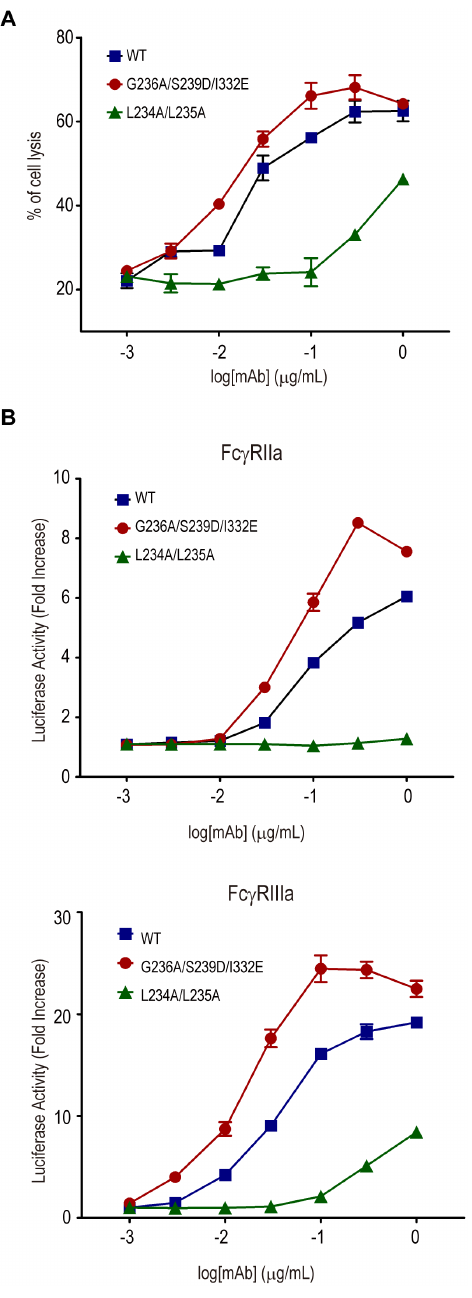
Figure 2. Activation of Jurkat/Fc c R/NFAT-Luc cells by CD20- bound rituximab. (A) Daudi and human PBMC were co-cultured (the effector to target cell ratio was 20:l) in the presence of serially diluted rituximab or its Fc-engineered variants: G236A/S239D/I332E with higher Fc c R binding and L234A/L235A with lower Fc c R binding. Percentage cytotoxicity calculated by LDH activity released from damaged cells is represented on the graphs. The assays were performed in triplicate, and the data are the mean 6 SEM. The rituximab G236A/S239D/I332E variant exhibited ADCC activity (EC 50 =0.013 m g/ml) more strongly than wild-type rituximab (EC 50 =0.023 m g/ml) (p , 0.05, Graphpad Prism Software). (B) Daudi and Jurkat/Fc c R/NFAT-Luc cells were co-cultured in the presence of serially diluted rituximab or its Fc-engineered variants. Luciferase activity (i.e., the fold increase compared to the control sample without mAbs) is represented on the graphs. The assays were performed in triplicate, and the data are the mean 6 SEM. Jurkat/ Fc c RIIa/NFAT-Luc cells were activated by the rituximab